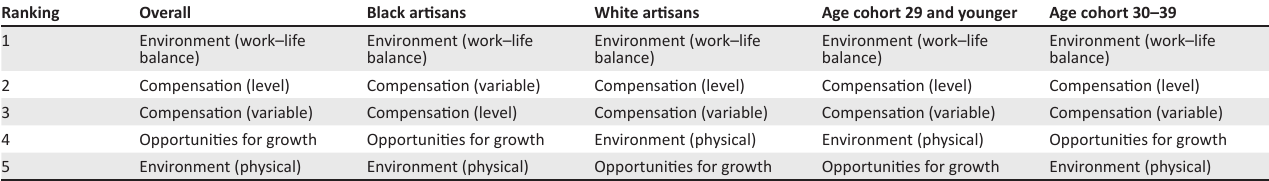
TABLE 11: Ranked attributes overall and per demographic group.